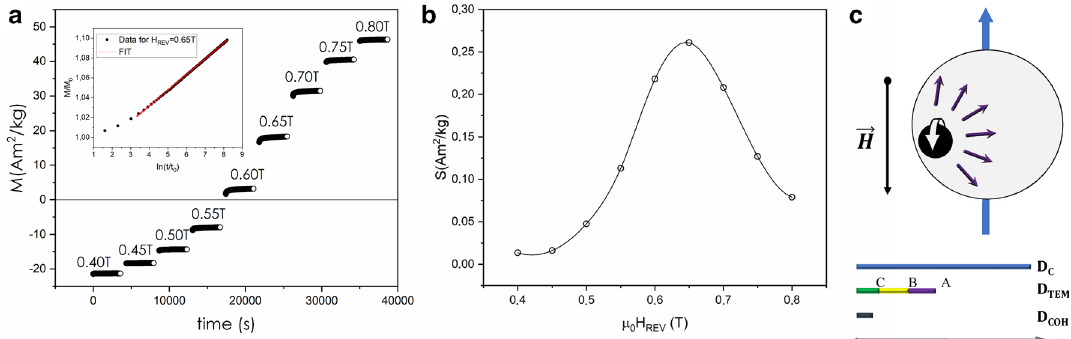
Figure 6. ( a ) Time dependent magnetization curves for SFO C measured at different values of reverse field H REV (indicated next to the experimental data) after saturation at − 5 T, at 300 K (Magnetization is normalized to the weight of sample); for clarity, the inset shows the experimental data (black circles) for 0.65 T field with the best fit (red line) (Magnetization is normalized to the initial value M 0 = M(t 0 ) ); ( b ) corresponding magnetic viscosity ( S ) as a function of the reverse field for SFO C (line is a guide to the eye); ( c ) scheme of activation mechanism with details of physical/magnetic length